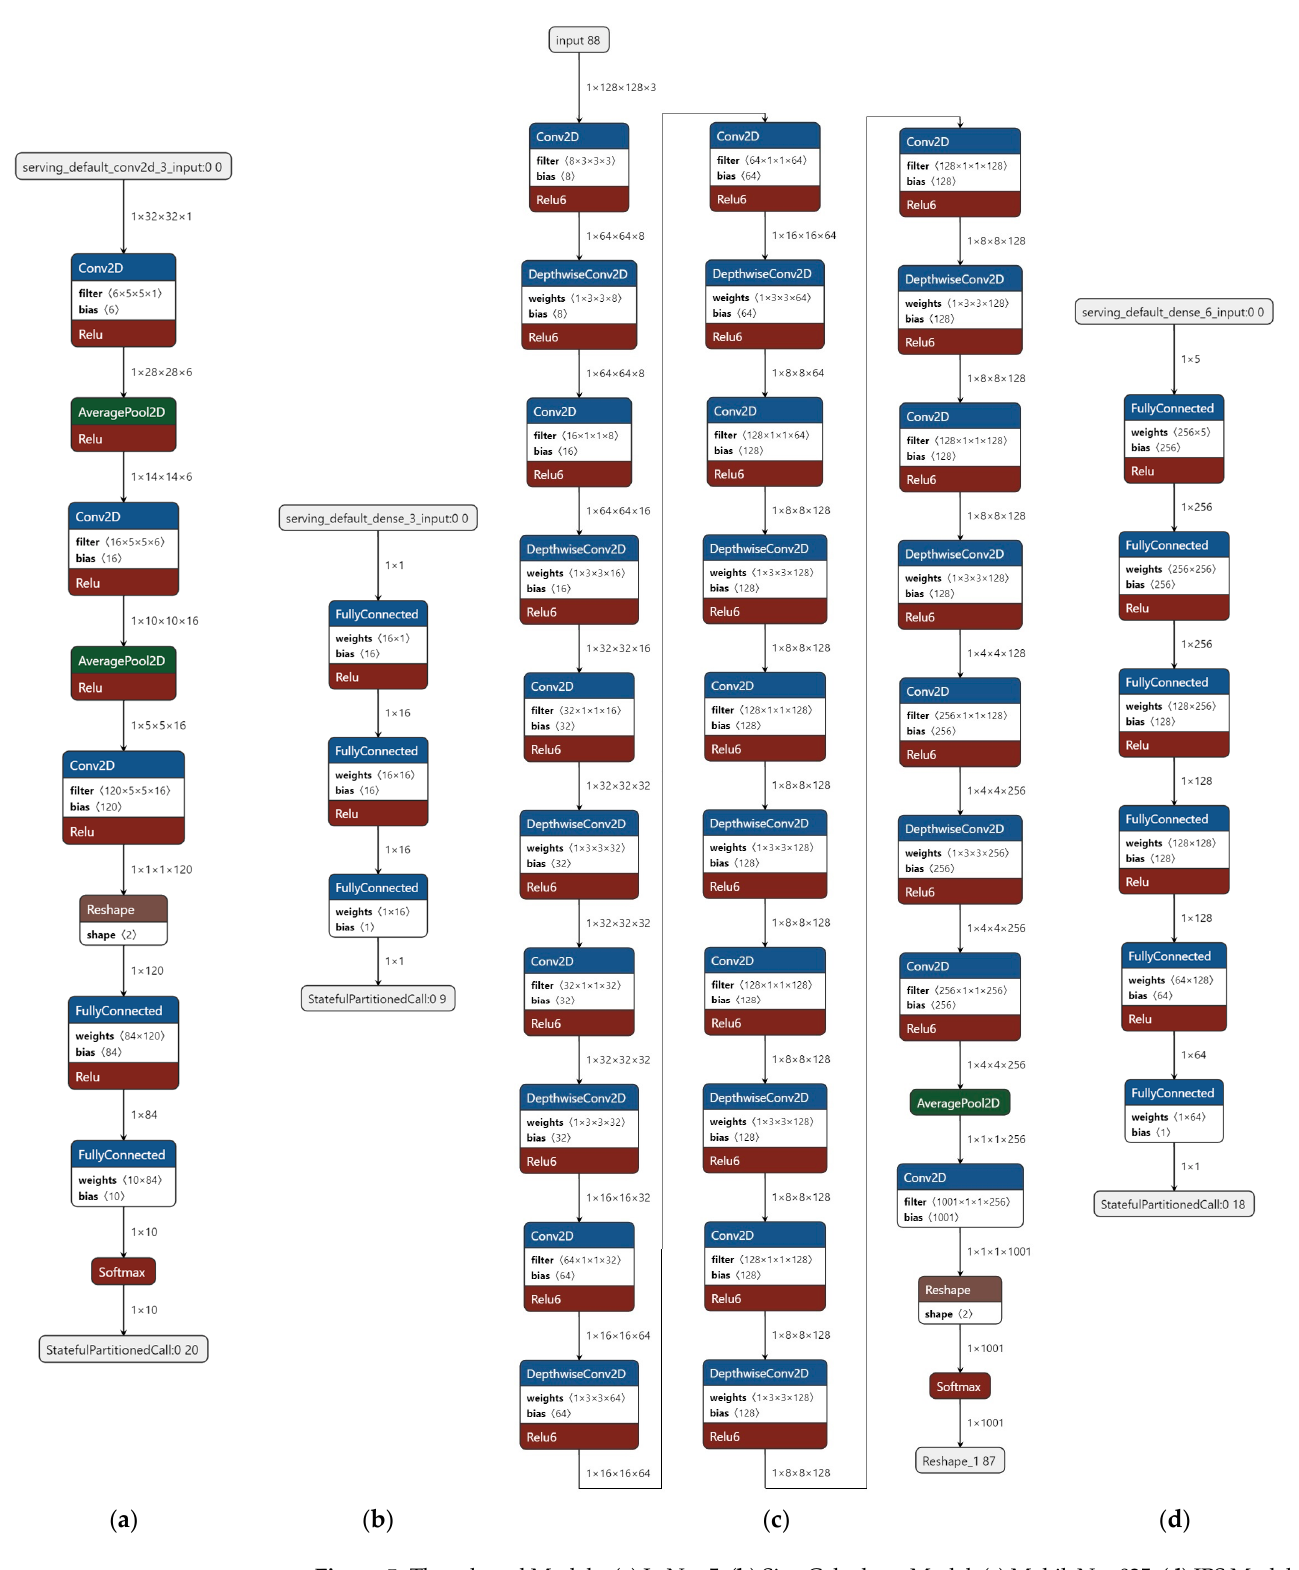
Figure 5. The selected Models. ( a ) LeNet-5, ( b ) Sine Calculator Model, ( c ) MobileNet-025, ( d ) IPS